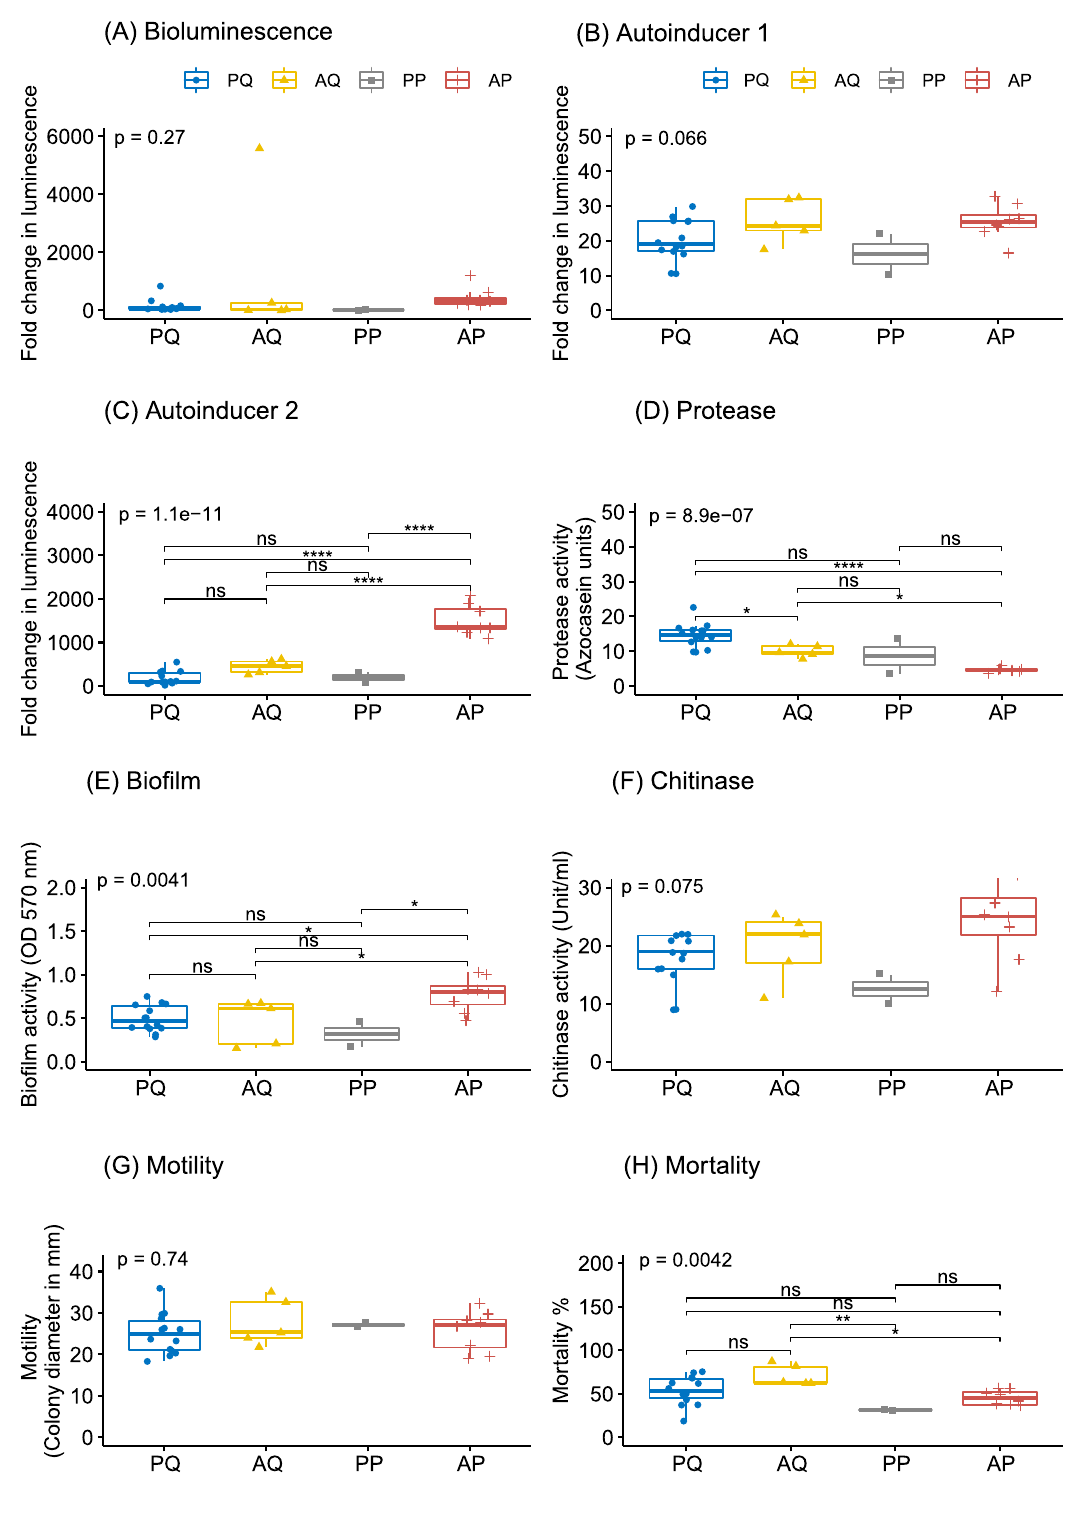
Figure 5. Box plot analysis of virulence markers and pathogenicity in Vibrio campbellii isolates among the variants of ToxR. ( A ) Luminescence, ( B ) Autoinducer 1 (AI-1), ( C ) Autoinducer 2 (AI-2), ( D ) Protease, ( E ) Biofilm, ( F ) Chitinase, ( G ) Motility ( H ) Mortality. One way ANOVA followed by Tukey post hoc comparison was carried out using rstatix package. The graphics were prepared using ggpubr package in R4.0.2. The